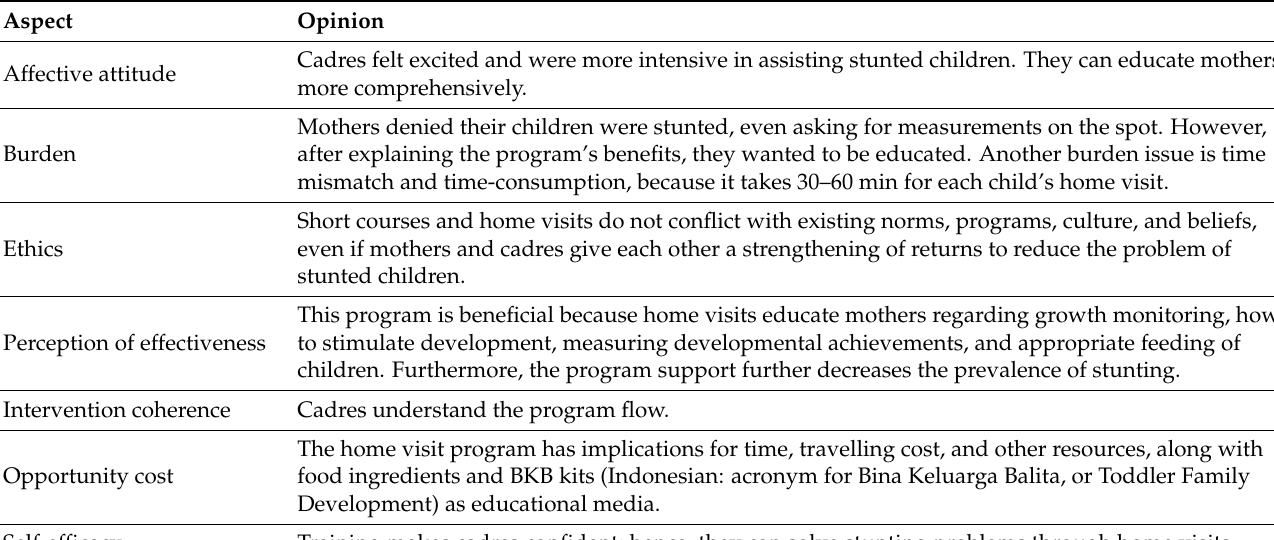
Table 4. Adequacy of a short course for cadres in implementing home